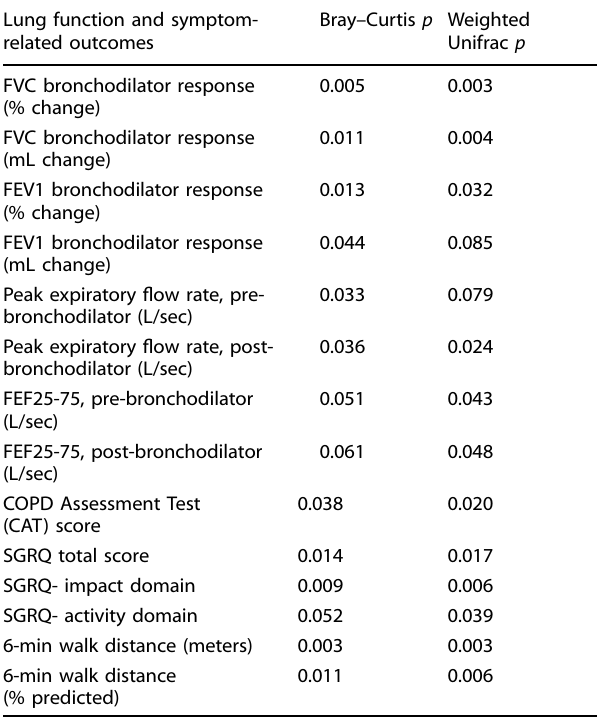
Table 2. Clinical features associated with differences in lung bacterial community structure (N = 181